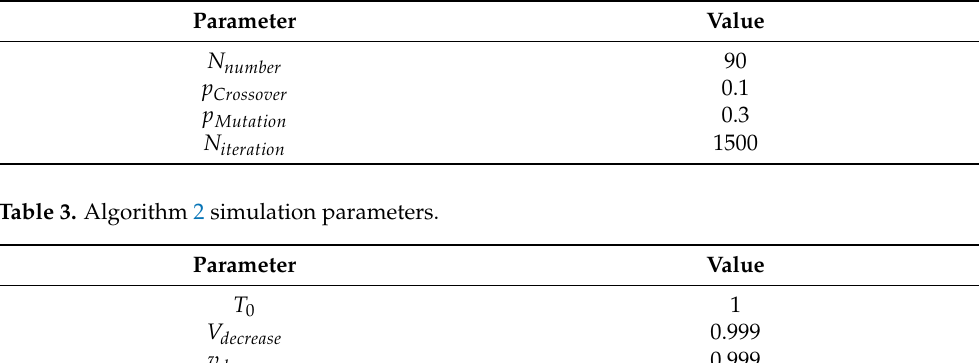
Table 2. Algorithm 1 simulation parameters.